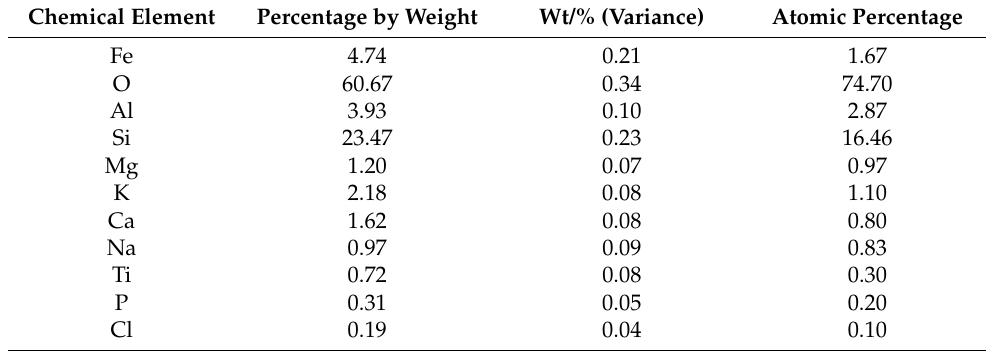
Table 5. Composition of Sample